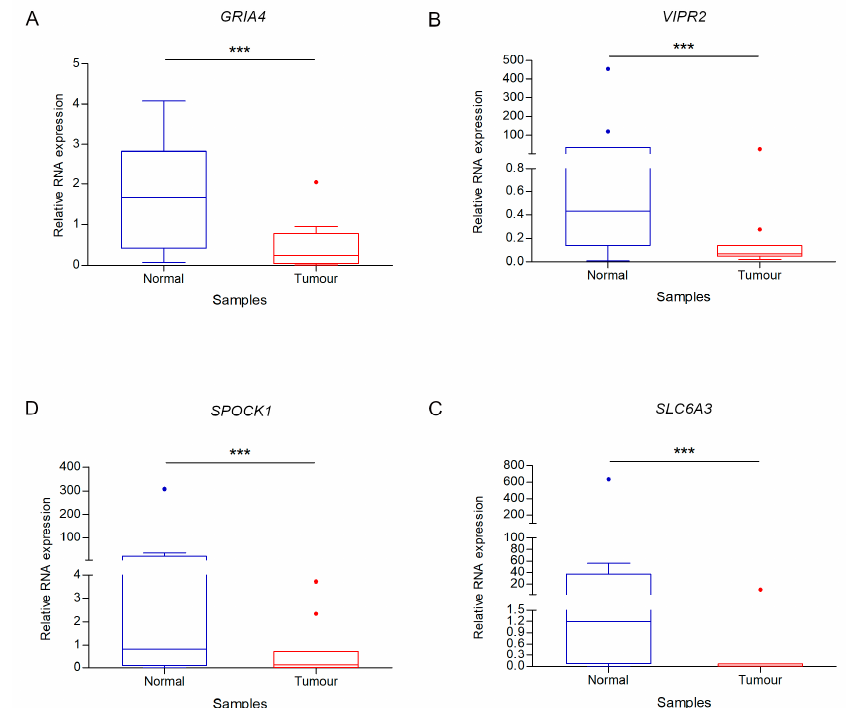
Figure 3. Di ff erential gene expression analysis between tumour and normal samples. Box plot fold change values of GRIA4 ( A ), VIPR2 ( B ), SPOCK1 ( C ) and SLC6A3 ( D ) for CRC and control samples. *** indicates p value < 0.0001.